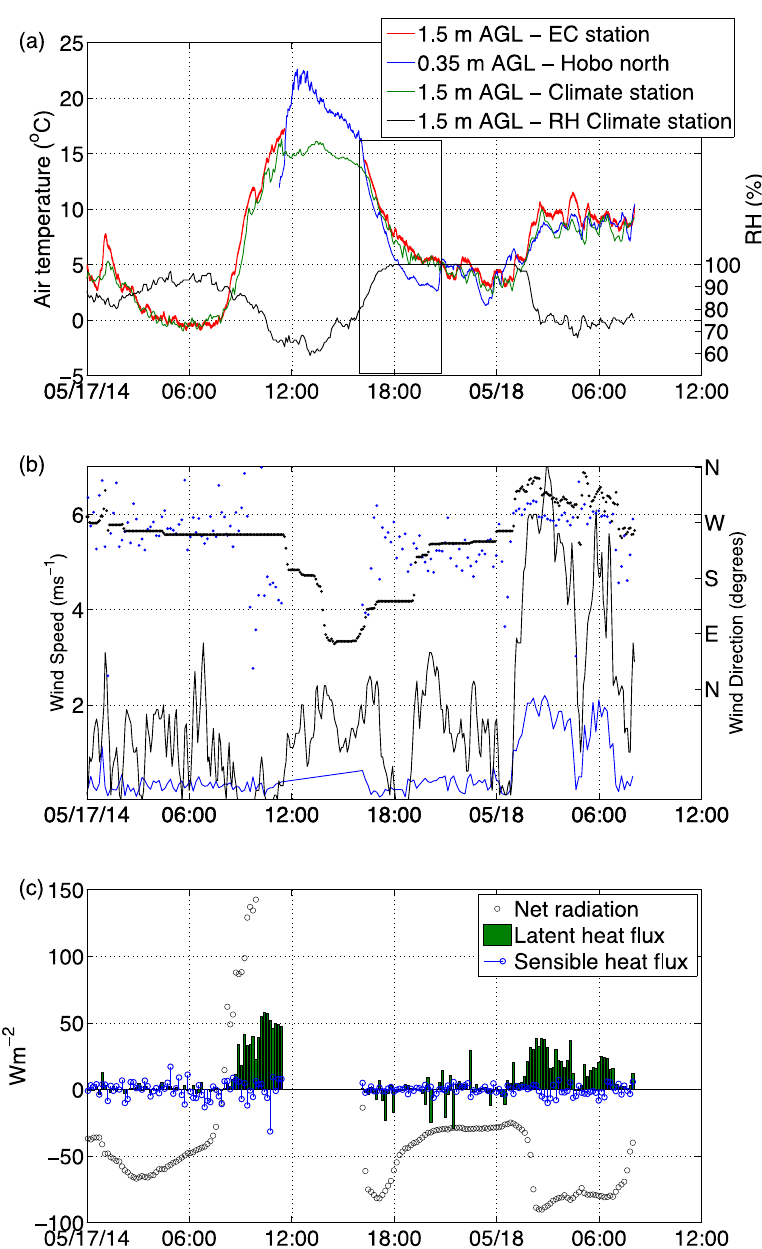
Figure 2. ( a ) Air temperature and relative humidity from within and above the vineyard canopy. The climate station data was collected from a low escarpment around 5 m above the canopy’s horizon. The black box shows the time period of the operation of the infrared cameras; ( b ) Wind speed (line) and direction (dotted) from within (blue) and above (black) the canopy; ( c ) The surface radiation and turbulent energy budget from the eddy covariance system inside the canopy.